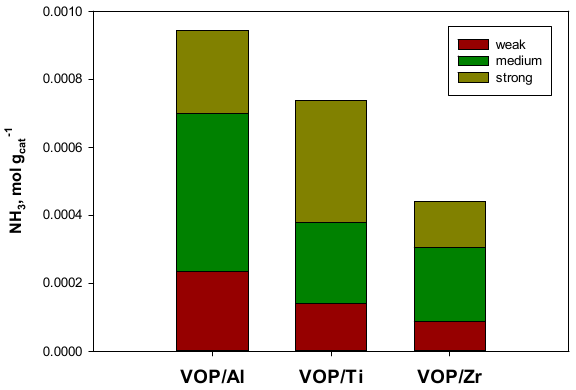
Figure 4. Overall and partial ammonia amounts desorbed from the VOP/x catalysts during NH 3 - TPDs.